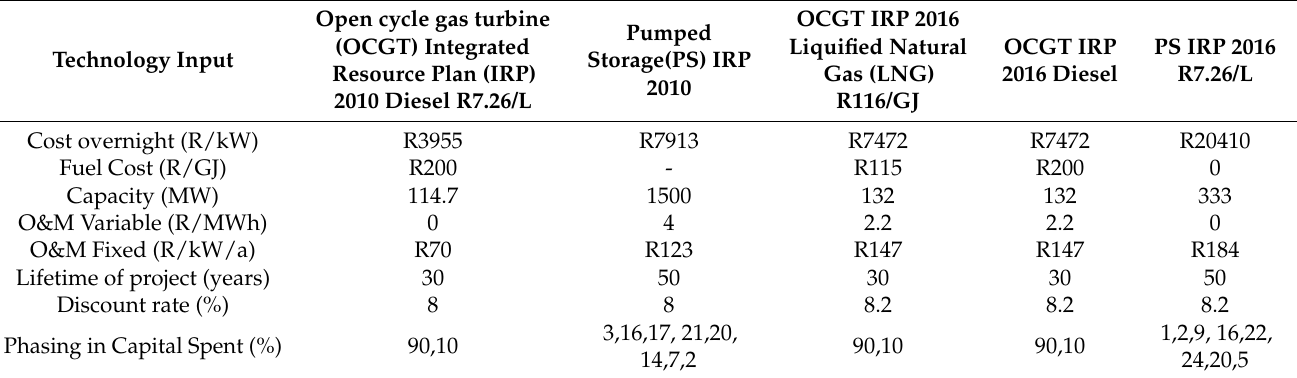
Table 1. Input parameters from IRP 2010 and 2016.